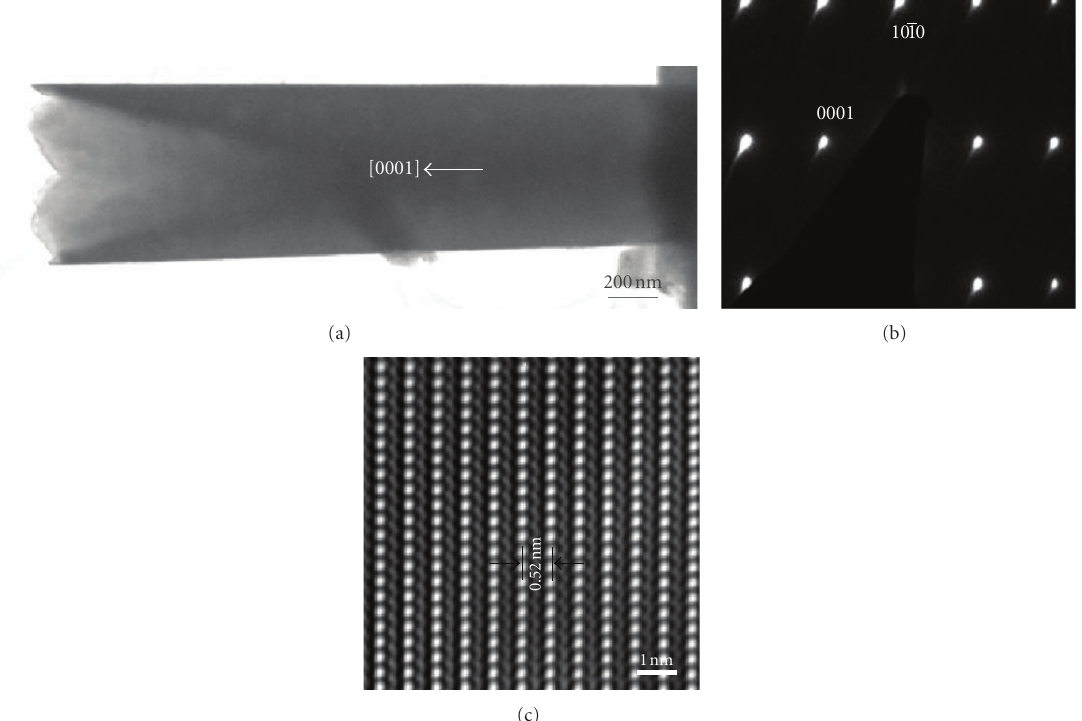
Figure 2: (a) High-resolution TEM image of a single ZnO nanotube showing the hollow structure with etching depth. (b) SAED pattern of single nanotube. (c) HRTEM image of the ZnO nanotubes.